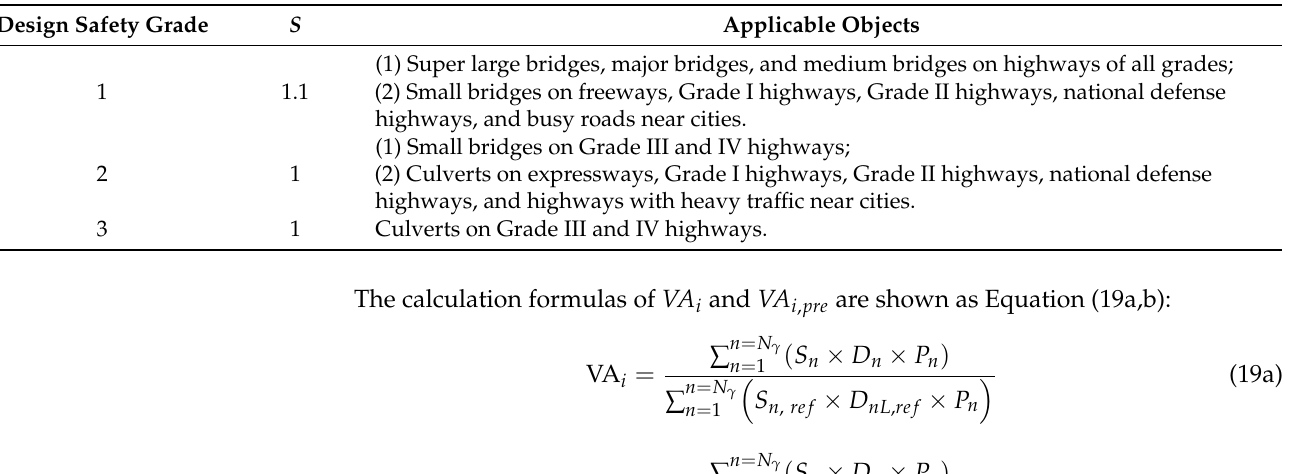
Table 1. S values according to design safety grade.